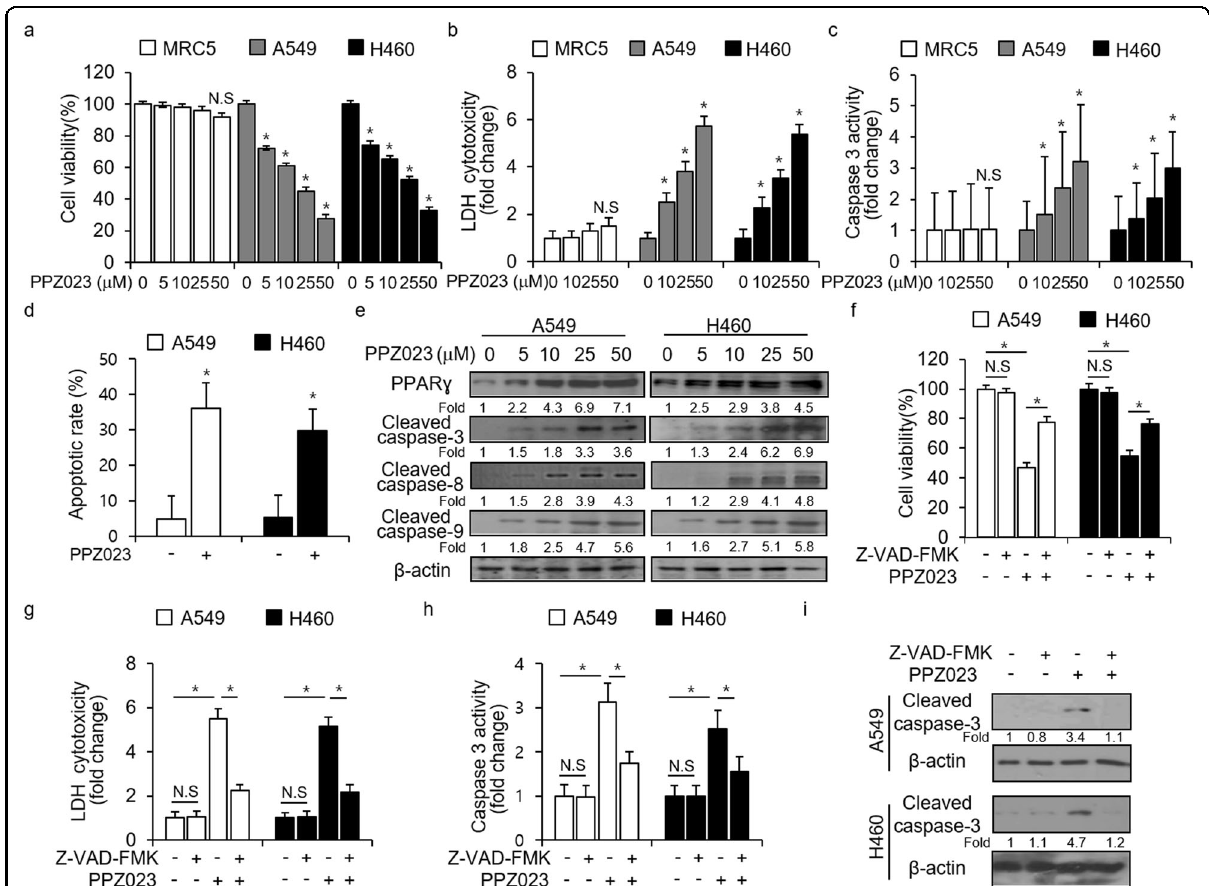
Fig. 2 PPZ023 treatment induces caspase-dependent cell death in NSCLC cells. a – c MRC5, A549, and H460 cells were treated with PPZ023 at the indicated doses. WST-1 assays, LDH assays, and caspase-3 activity assays were performed under these condition; * p < 0.05. d Flow cytometry analysis of annexin-V-FITC and propidium iodide staining analyzed in PPZ023 (25 μ M, 24 h)-treated A549 and H460 cells; * p < 0.05. e Western blot analysis of PPAR ɣ , cleaved caspase-3, and caspase-9 after treatment with PPZ023 (25 μ M, 24 h) in A549 and H460 cells. β -Actin was used as the protein loading control. f – i A549 and H460 cells were treated with Z-VAD-FMK (50 μΜ ) and PPZ023 (25 μ M, 24 h). Cell viability, cell cytotoxicity, and caspase-3 activity were determined using WST-1, LDH, and caspase-3 activity assays; * p < 0.05. Protein samples were analyzed by western blotting of cleaved caspase-3. β -Actin was used as the protein loading